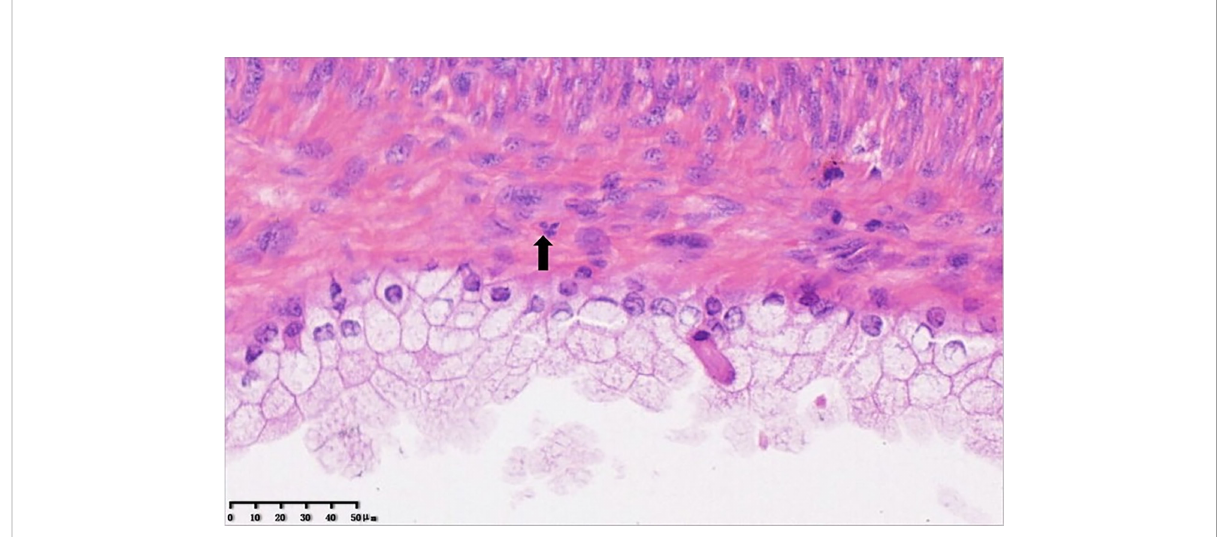
FIGURE 3 Cellular stroma composes of atypical mitotically active spindle cells (×40).